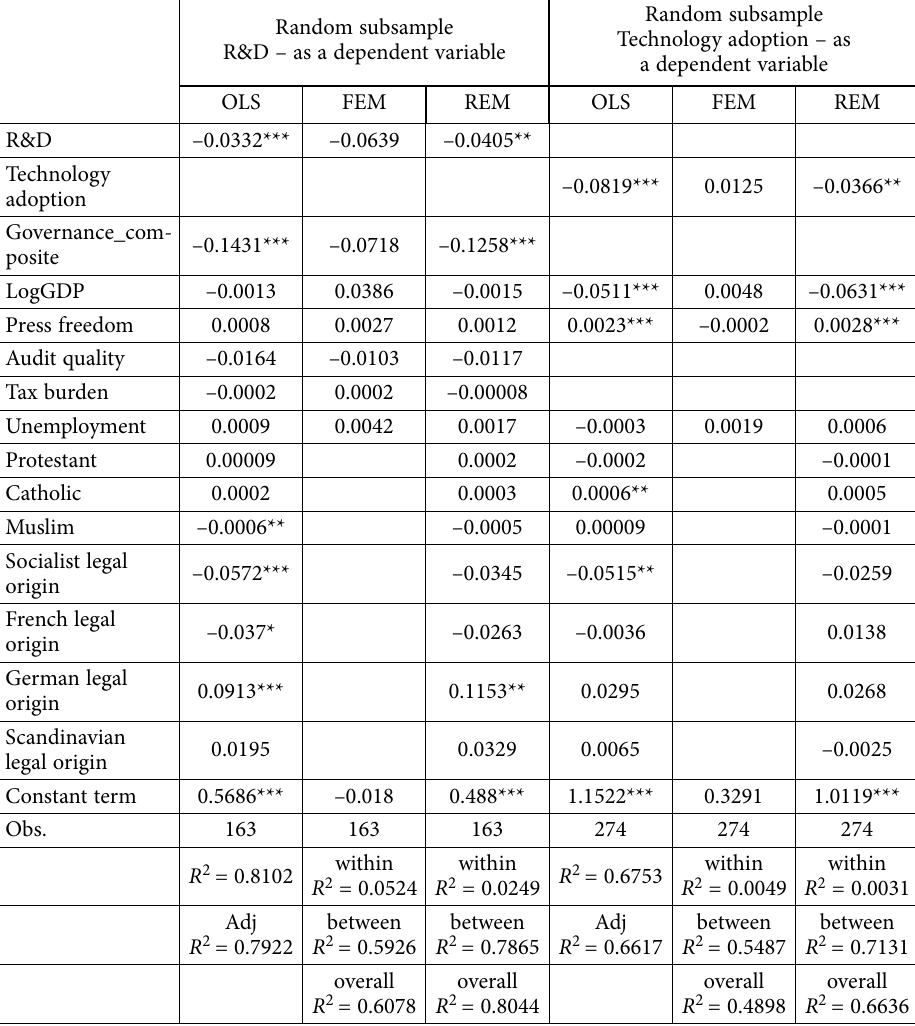
Table 8. Robustness checks. Random subsample. R&D and Technology adoption as dependent variable Regression results for Economic and financial crime ( CSL index ) as a function of R&D/Technology adoption Random subsample Random subsample Technology adoption – R&D – as a dependent variable